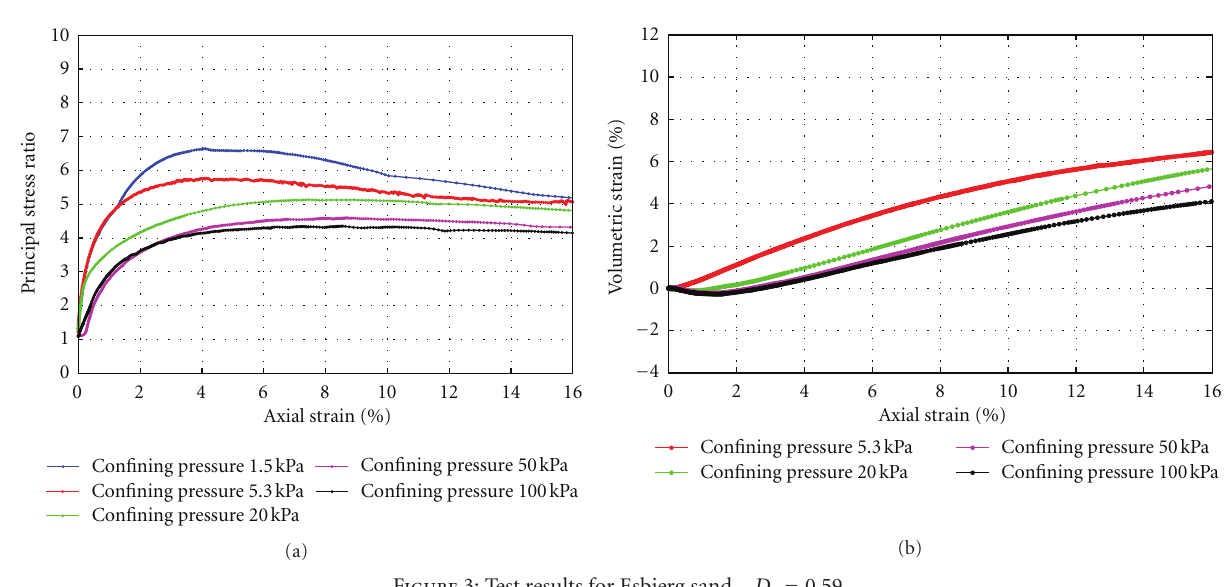
Figure 3: Test results for Esbjerg sand— D r = 0 .